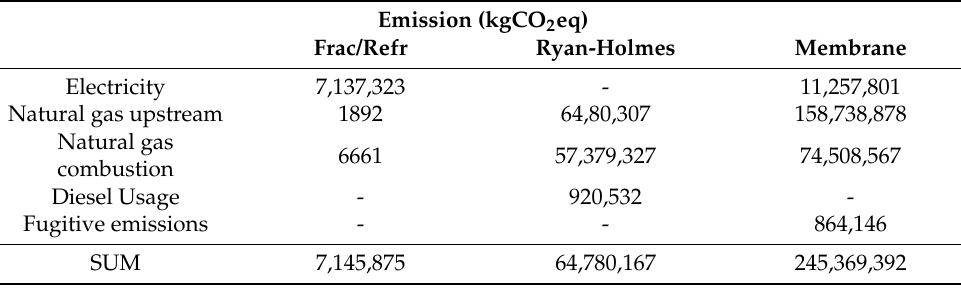
Table 5. Mass Emissions of major components of gas Separation